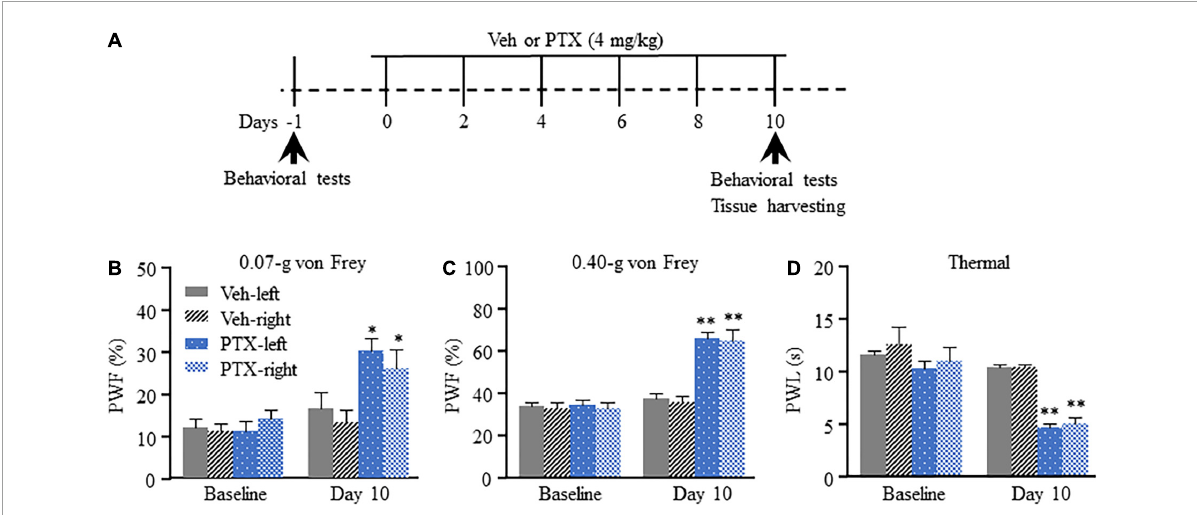
FIGURE1 Mechanical allodynia and thermal hyperalgesia induced by paclitaxel (PTX) in mice. (A) A schematic of drug administrations and behavioral tests showed that mice were intraperitoneally injected with PTX (4 mg/kg) or vehicle solution (200 µ l) every other day for a total of six times. (B–D) The paw withdrawal frequency (PWF) in response to a 0.07-g (B) and 0.40-g (C) von Frey filament, and the paw withdrawal latency (PWL), in response to thermal stimulation (D) , were assessed on day 10 after the first injection using PTX, and were compared with those of mice in the vehicle (Veh)-treated group. n = 12/group. Results are presented as mean ± SEM; ∗ P < 0.05, ∗∗ P < 0.01, compared with vehicle group by two-way ANOVA followed by post hoc Tukey